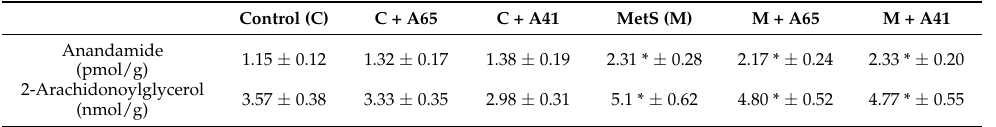
Table 1. Kidney content of anandamide and 2-arachidonoylglycerol.